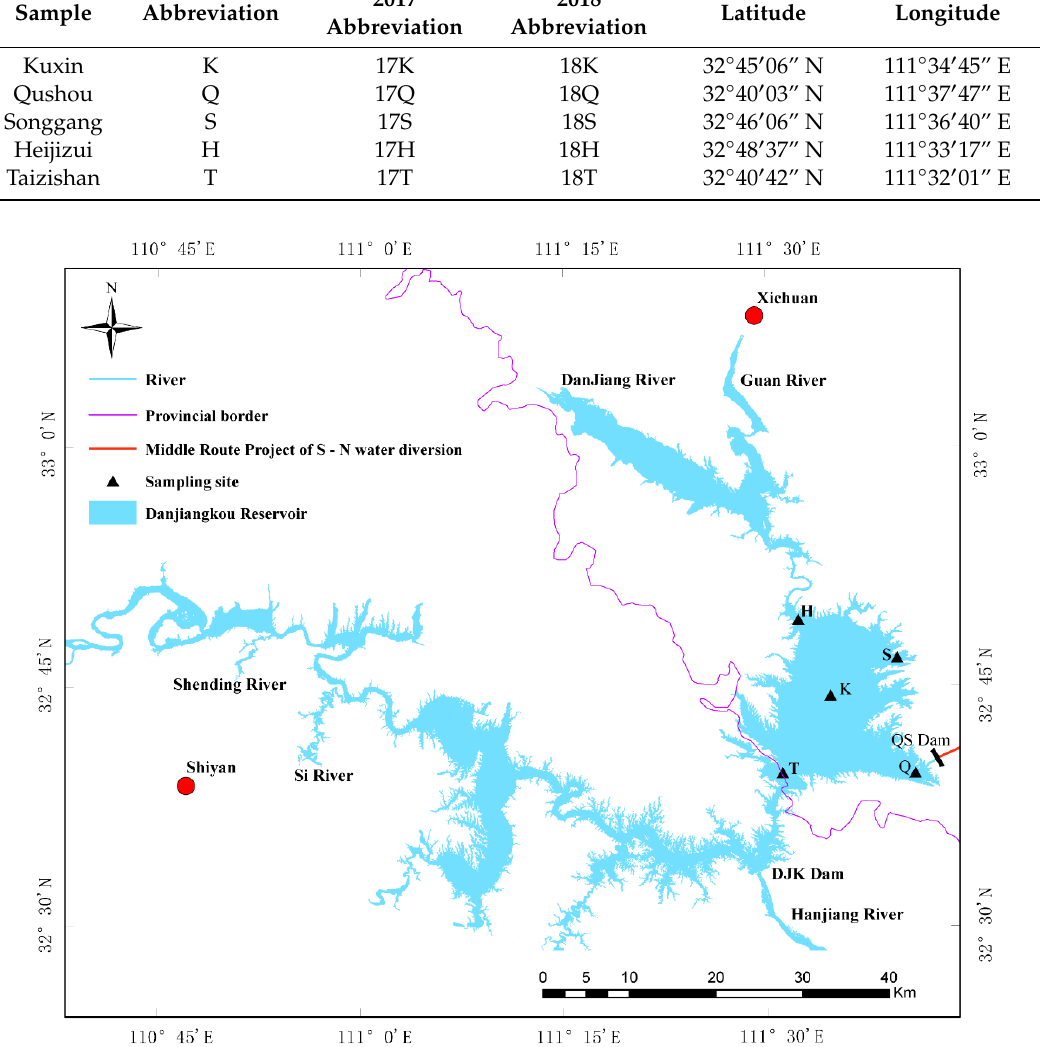
Figure 1. Map of the locations of the sampling sites in the Danjiangkou Reservoir.